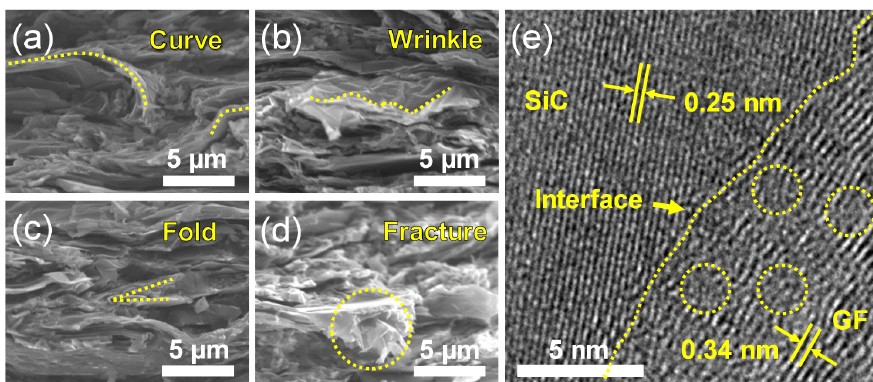
Fig. 9 GF with different defects in SiC/GF composites: (a) curve, (b) wrinkle, (c) fold, and (d) fracture. (e) HRTEM image of SiC/GF interface.